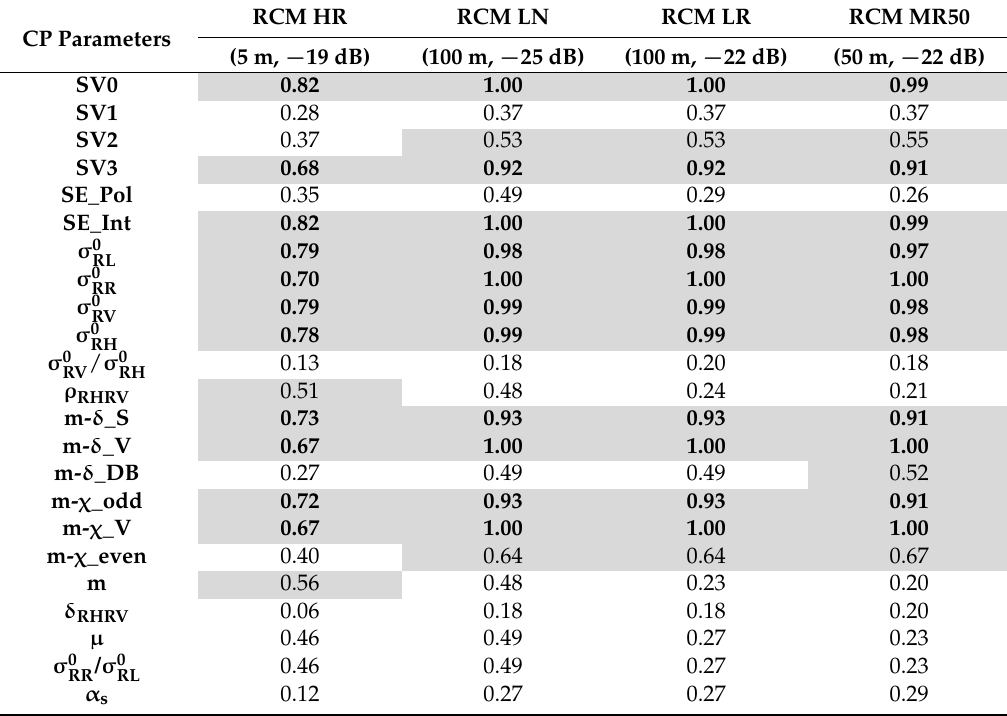
Table 3. K-S distance between FYI and MYI in RCM HR, LN, LR and MR50 modes. Highlighted cells in gray indicate CP parameters with K-S distance > 0.5. CP Parameters with K-S distance values in bold are parameters with discrimination capability between FYI and MYI in the four RCM